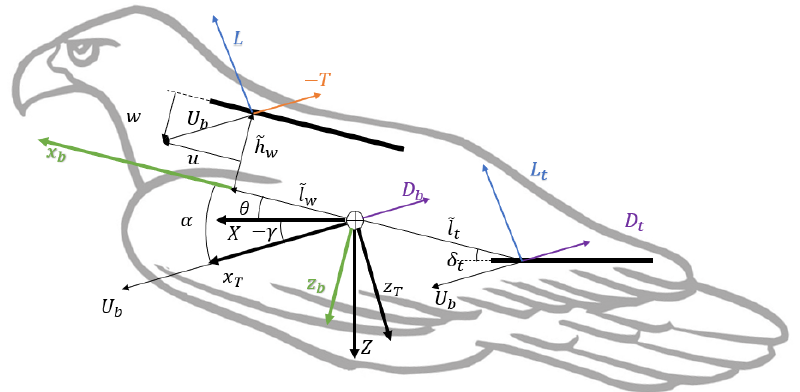
Figure 1. Scheme of forces, axis, and control and state variables. All vectors are on the plane ( X , Z ) of the longitudinal